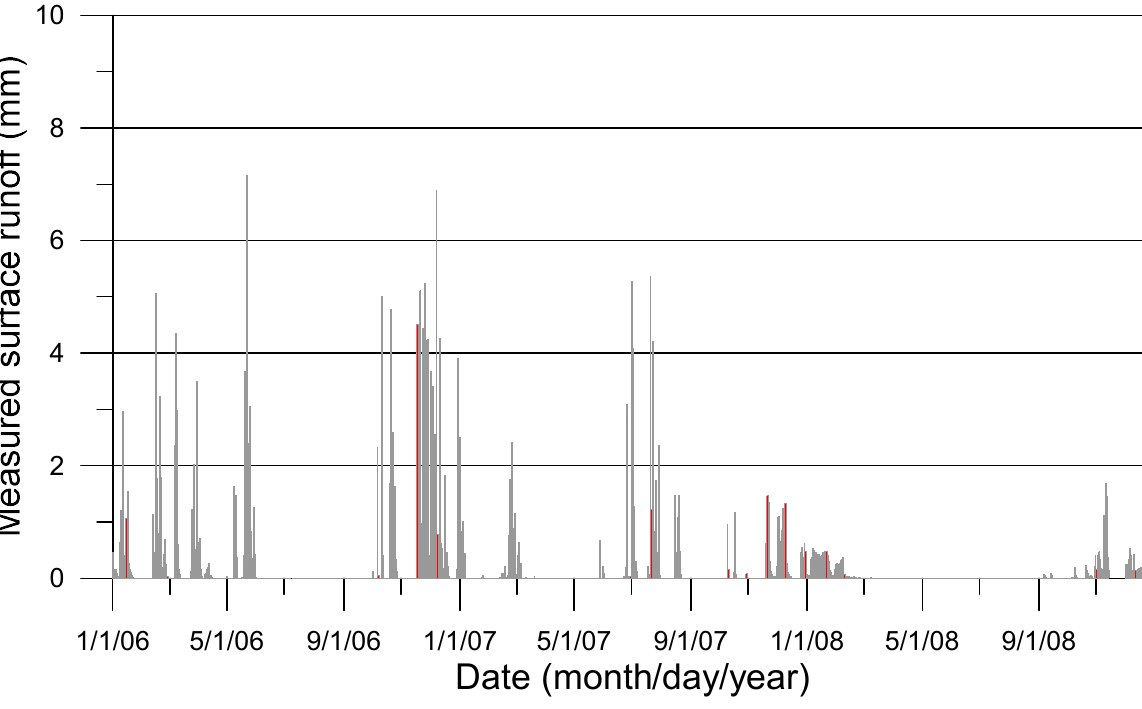
Figure 5. Measured daily runoff at Newbury cutting.